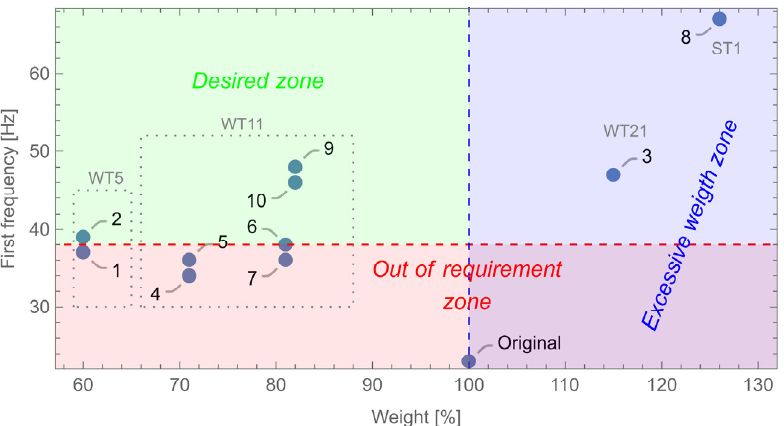
Figure 14. Investigated lattice structure modal analysis results versus panel weight.